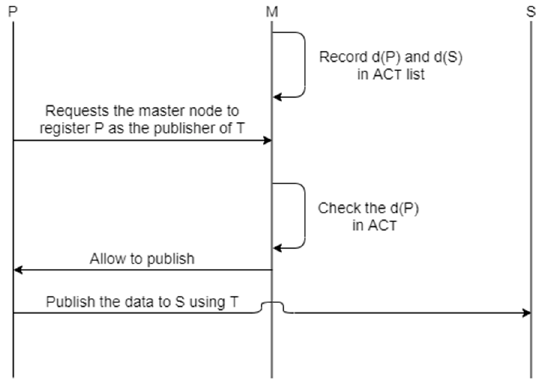
Figure 8. Proposed access control procedures. Table 2. The terms used in the framework.